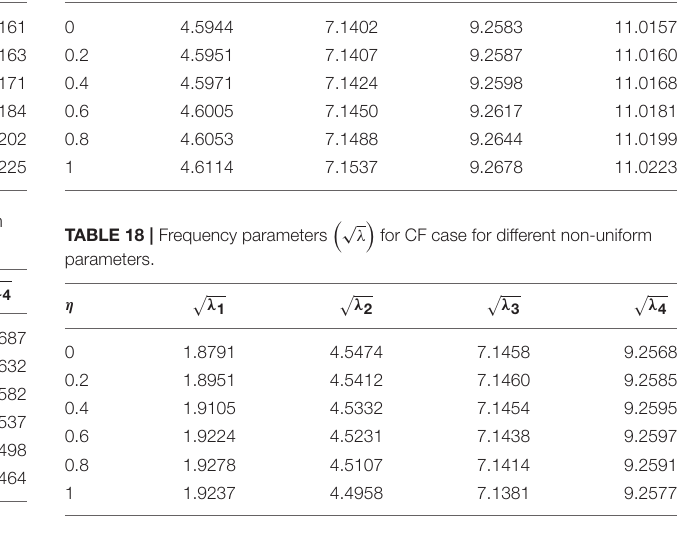
with µ 1 nm 2 and η 0.5. Graphical results are presented in = = Figure 4 , where variation of first four frequency parameters with L / h has been shown. From these tables, one may observe that frequency parameters increase with increase in length-to-height ratio except fundamental frequency parameter of CF